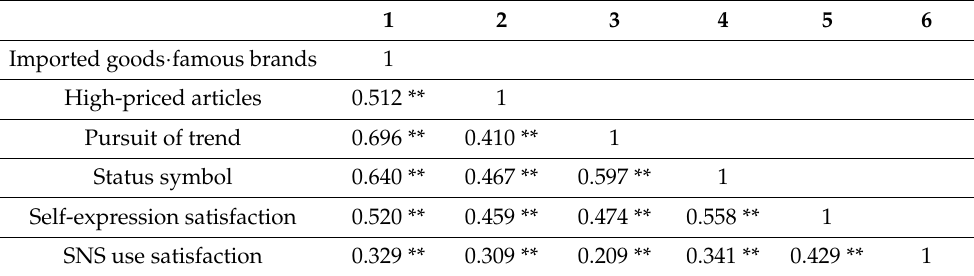
Table 5. Verification of